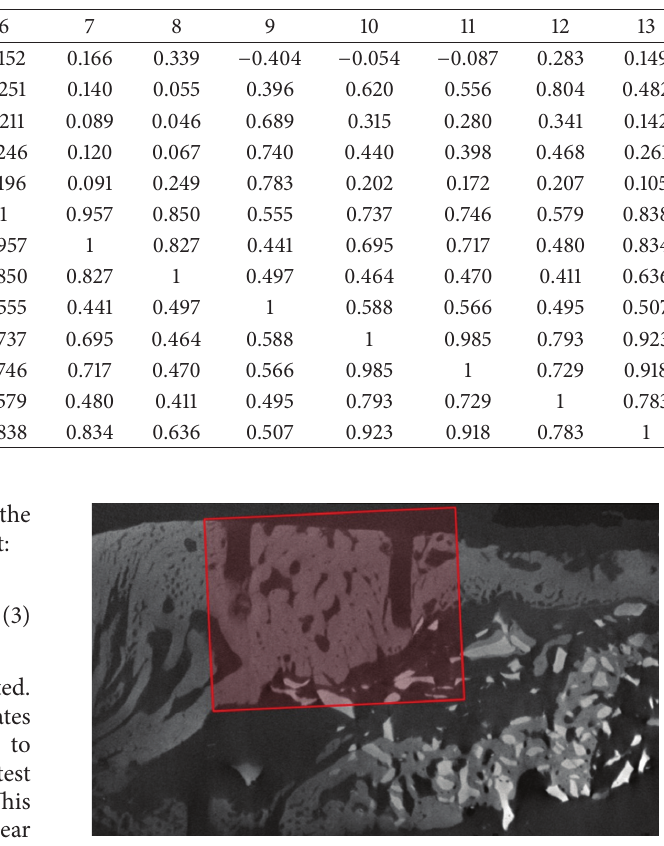
Table 2: Correlations matrix of the Raman bands and the reference spectra following the order: (1) Bio-Oss, (2) tricalcium phosphate, (3) Bio-Gide, (4) pork bone, (5) pork fat, (6) Amide I, (7) Amide III, (8) CH bending, (9) CH stretching, (10) phosphate bending ( ]